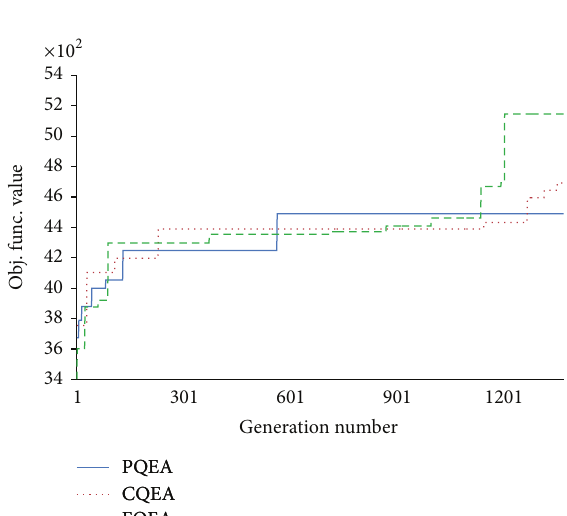
Figure 24: Convergence graph of PQEA, CQEA, and FQEA on 0-1 knapsack problem with multiple strongly correlated data instances with number of items, 𝑀 , being 5000 and capacity, 𝐶 , being 2% of total